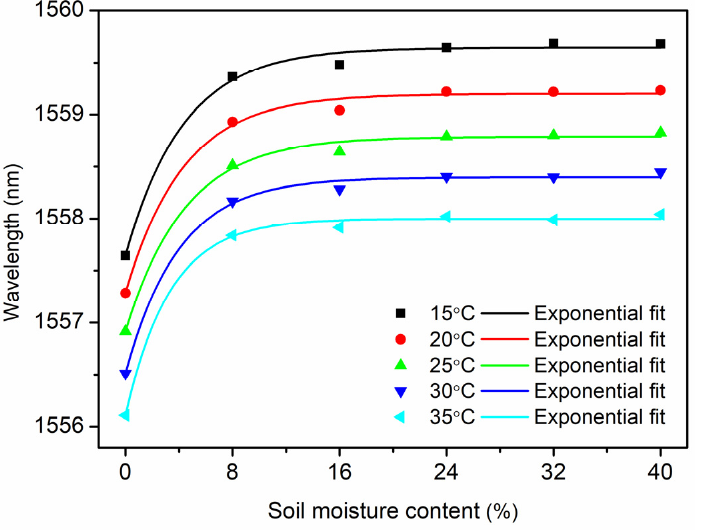
Figure 7. Bragg wavelength versus SMC at a constant temperature from 15 °C to 35 °C with a step of 5 °C.